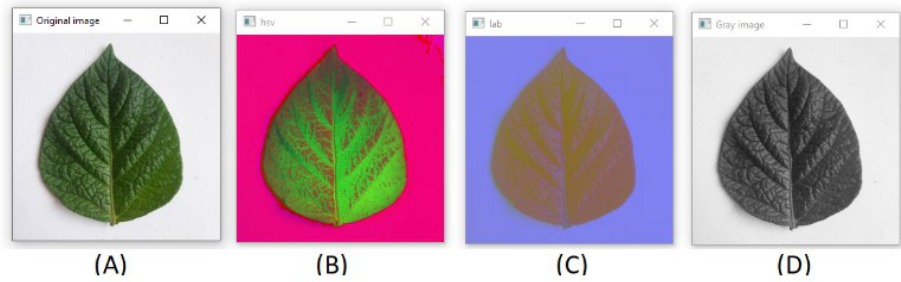
Figure 5. Transformation to HSV, LAB, and grayscale